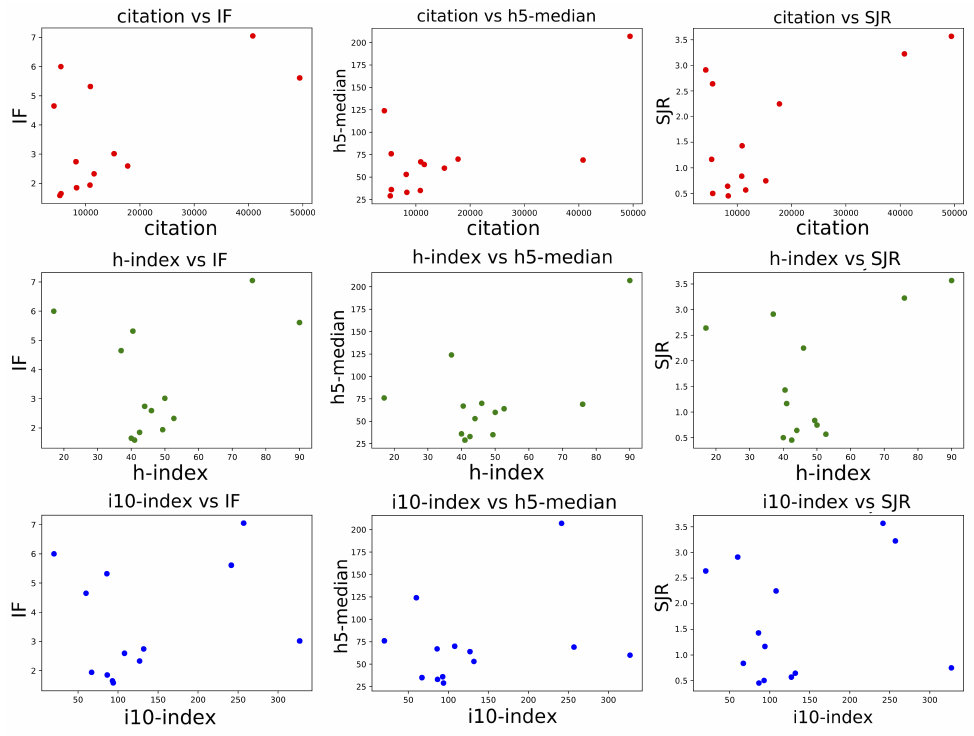
Figure 1. Plots of the BCB journal’s SJR, IF, and h5-median against various scholarly metrics of EiC.